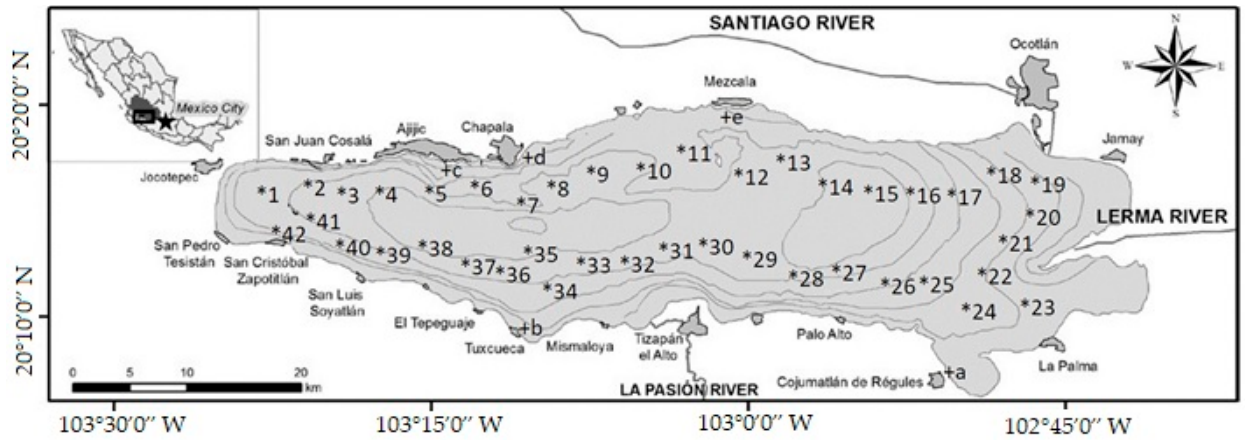
Figure 1. Map of Lake Chapala, adapted from Membrillo-Abad, Torres-Vera et al. 2016 [16], distribution of sediment, water, and fish samples. * With numbers; indicates sampling stations for water and sediments. + With letters; indicates fish sampling stations, also corresponds to landing of local fishermen (Cojumatlan de Regules, Tuxcueca, Ajijic, Chapala, and Mezcala).